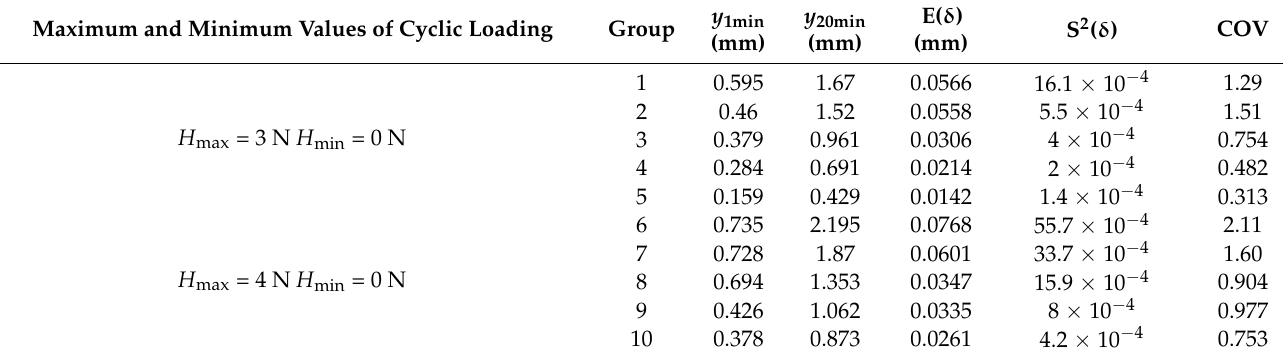
Table 5. Detailed data of pile top accumulated